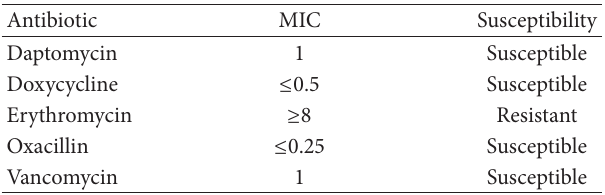
Table 3: Blood culture results and susceptibility profile for Staphy- lococcus epidermidis isolated from the atrial septal